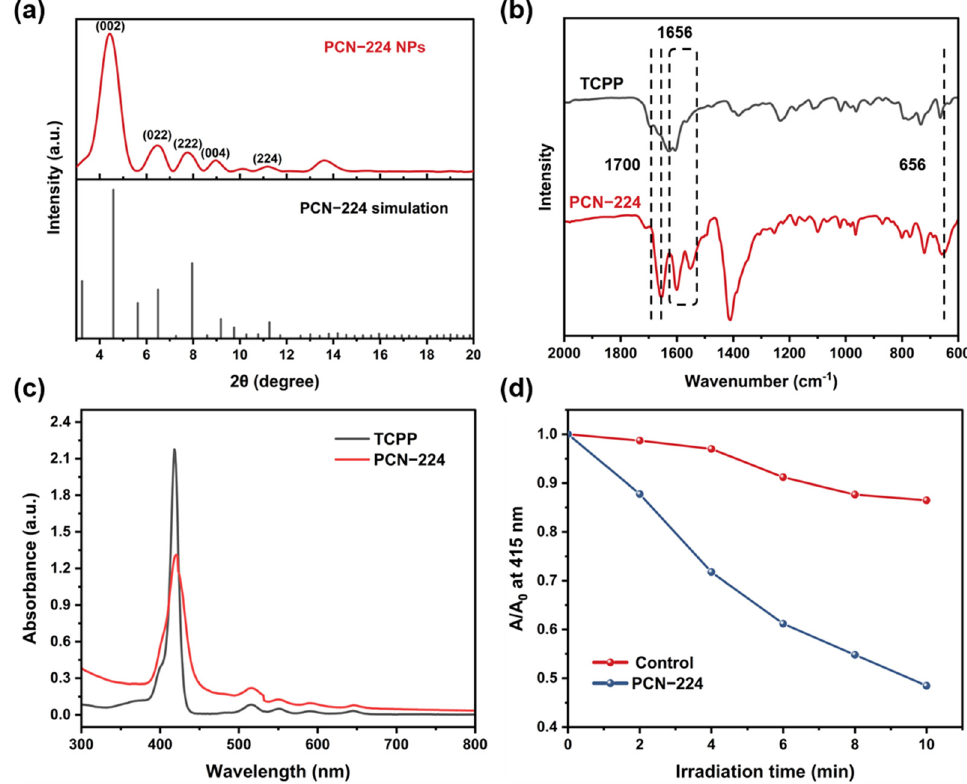
Figure 2. ( a ) Powder X-ray diffraction (PXRD) patterns of PCN − 224 NPs. ( b ) The Fourier transform infrared (FT-IR) spectra of PCN − 224 NPs and tetrakis (TCPP). ( c ) The ultraviolet (UV)-visible ab-